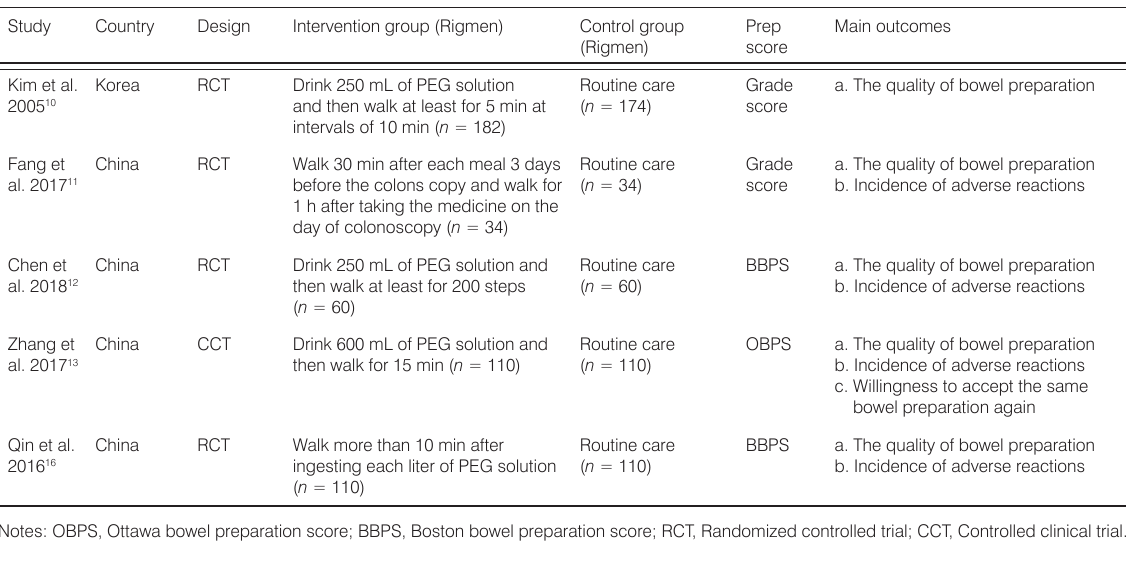
Table 1. Baseline characteristics of included studies.